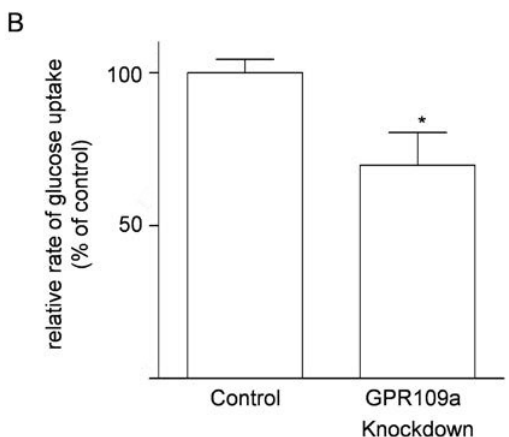
Figure 6. ( A ) Effects of siRNA knockdown of GPR109a on the expression of GPR109a protein in Caco-2 cells grown in 5.6 mM glucose. Western blot analysis showing the relative expression of niacin receptor in homogenates of cells prepared from the -ve negative (negative control siRNA, Silencer ® Select Negative Control siRNA, non-targeting SiRNA (HSS155269, HSS155270 and HSS155268). “Lipofetamine” contains only the lipofetamine